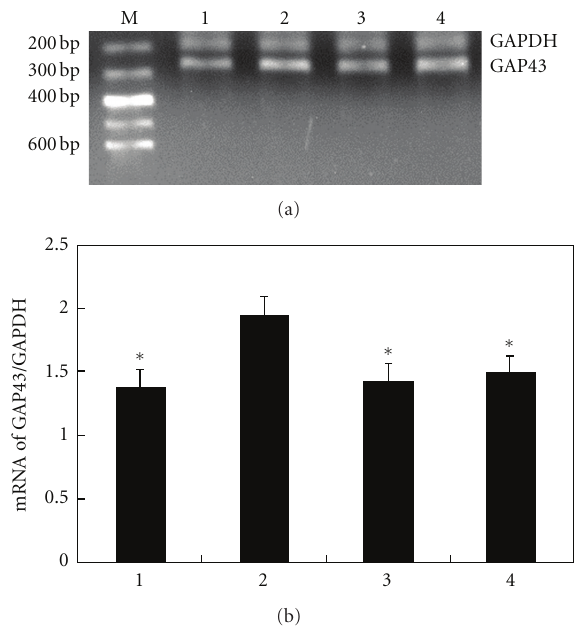
Figure 7: (a) RT-PCR products by electrophoresis of GAP43 and GAPDH in the infarct border zone. (b) Ratio of GAP43 band area operated group; 2: control ischemic group; 3: preischemic treat- ment group; 4: delayed application